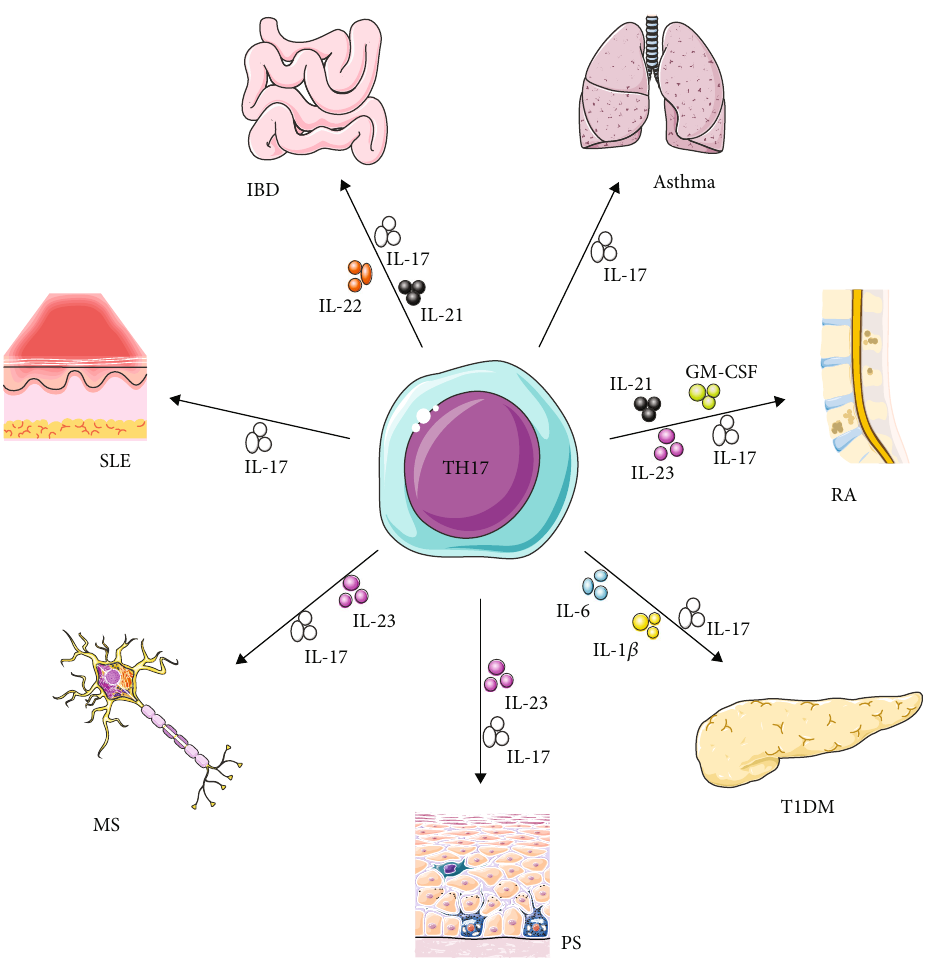
Figure 2: Functions of Th17